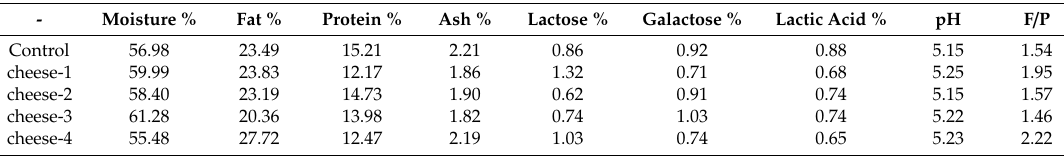
Table 1. Moisture, total fat, total proteins, ash, lactose, galactose, lactic acid, pH, and the fat to